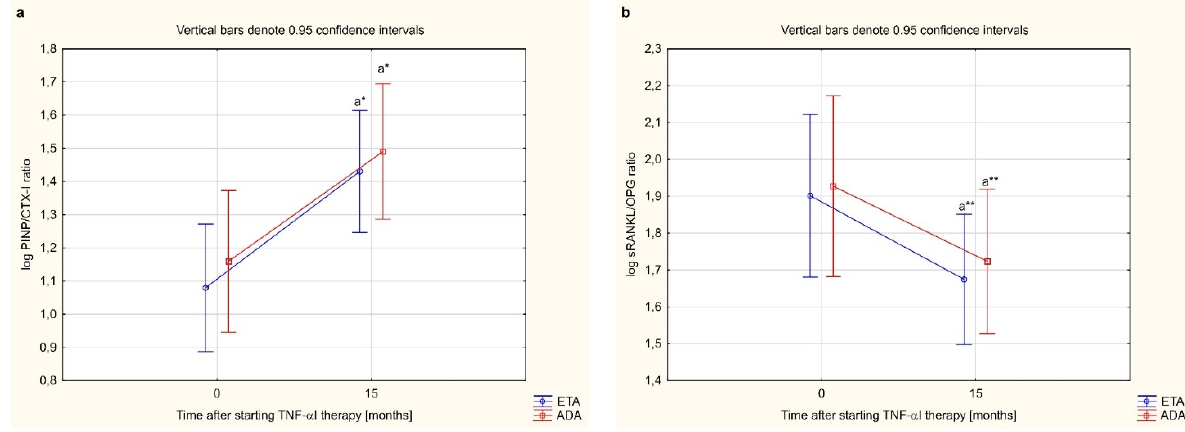
Figure 5. The effect of type TNF- α inhibitor used on PINP/CTX-I ( a ) and sRANKL/OPG ratios ( b ) in female rheumatoid arthritis patients during 15-month therapy. a * p < 0.01 or a ** p < 0.001 compared to the baseline. ADA, adalimumab; CTX-I, C-terminal cross-linking telopeptides of type I collagen; ETA, etanercept; OPG, osteoprotegerin; PINP, N-terminal propeptides of type I procollagen; RA, rheumatoid arthritis; sRANKL, total soluble receptor activator of nuclear factor κ B ligand; TNF αΙ, tumor necrosis factor- α inhibitors.